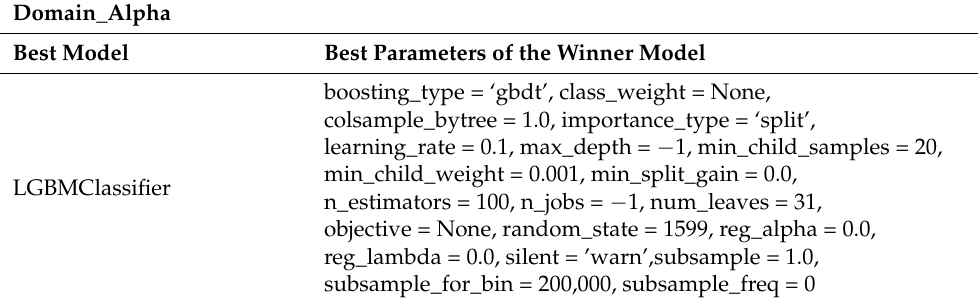
Table 2. Best parameters of the winner model of the Domain Alpha.